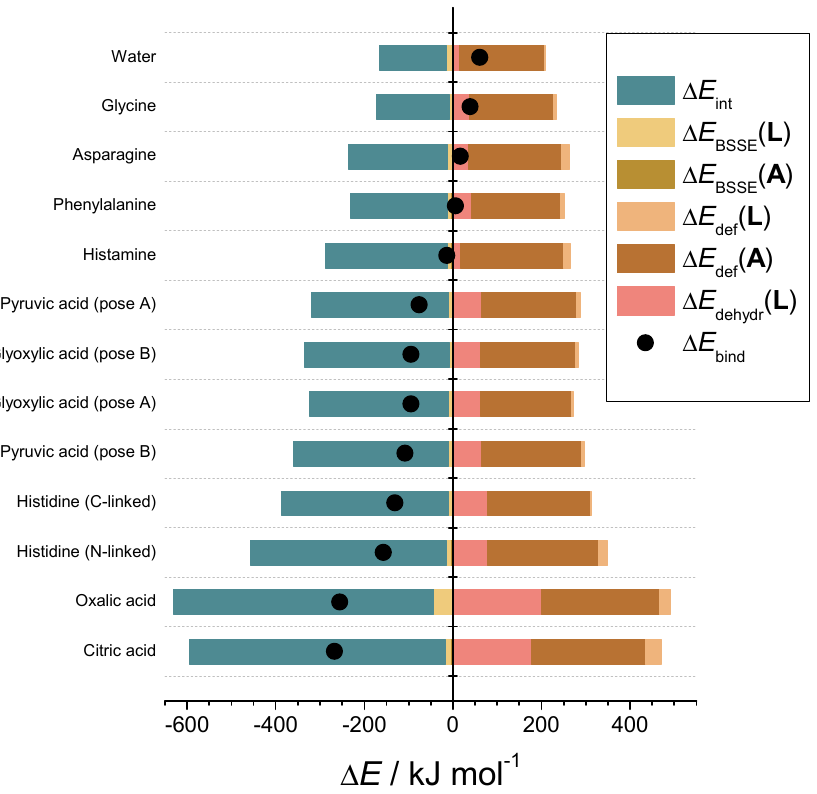
Figure 7. Total binding energies and contributions of interaction, deformation, dehydration and basis set superposition error.